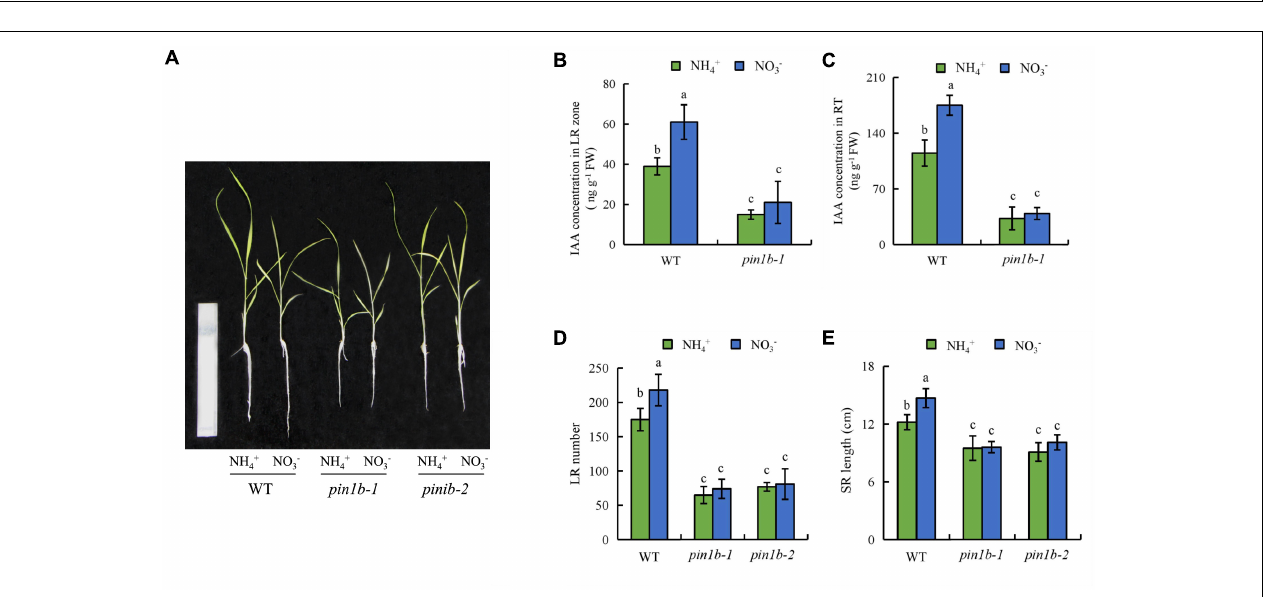
FIGURE 7 | qRT-PCR analysis of PIN family genes in rice seedlings. Seedlings were grown in hydroponic medium containing NH 4 + and NO 3 − for 14 days. Relative mRNA levels were normalized for individual gene relative to Os ACT . Data are means ± SE and bars with different letters in the same gene indicate significant difference at P < 0.05 tested with ANOVA.